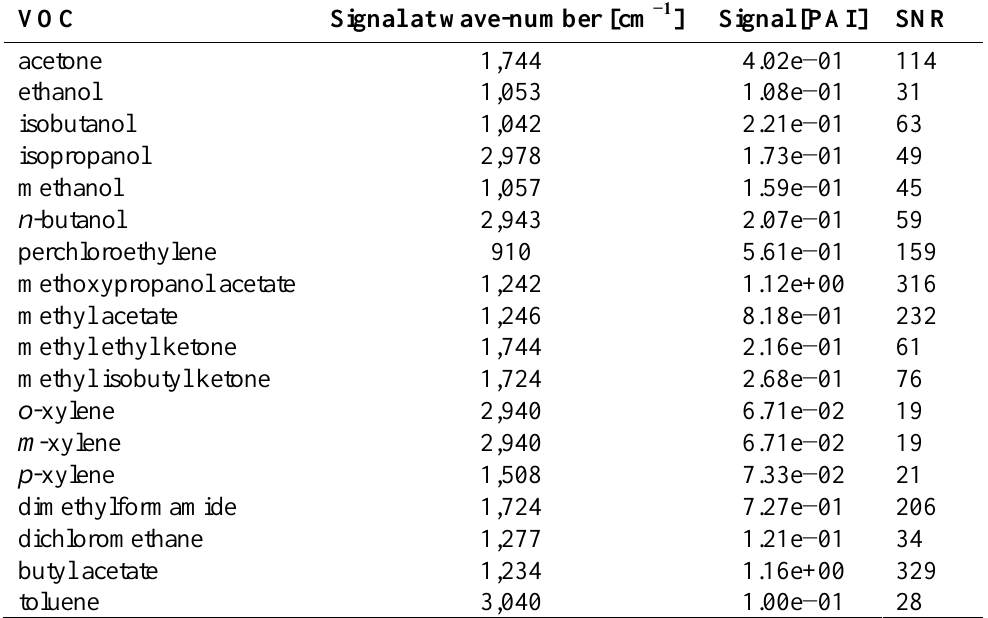
Table 3. Signal to noise ratio (SNR) and its calculation parameters for each VOC: wavelength where the signal was taken and corresponding signal height. N is the RMS noise of the region 2,400–2,800 cm −1 with the magnitude of one standard deviation (1σ). N is for all VOCs 3.53e−3, since the standard deviation was averaged over all VOCs. The concentration of each VOC was 100